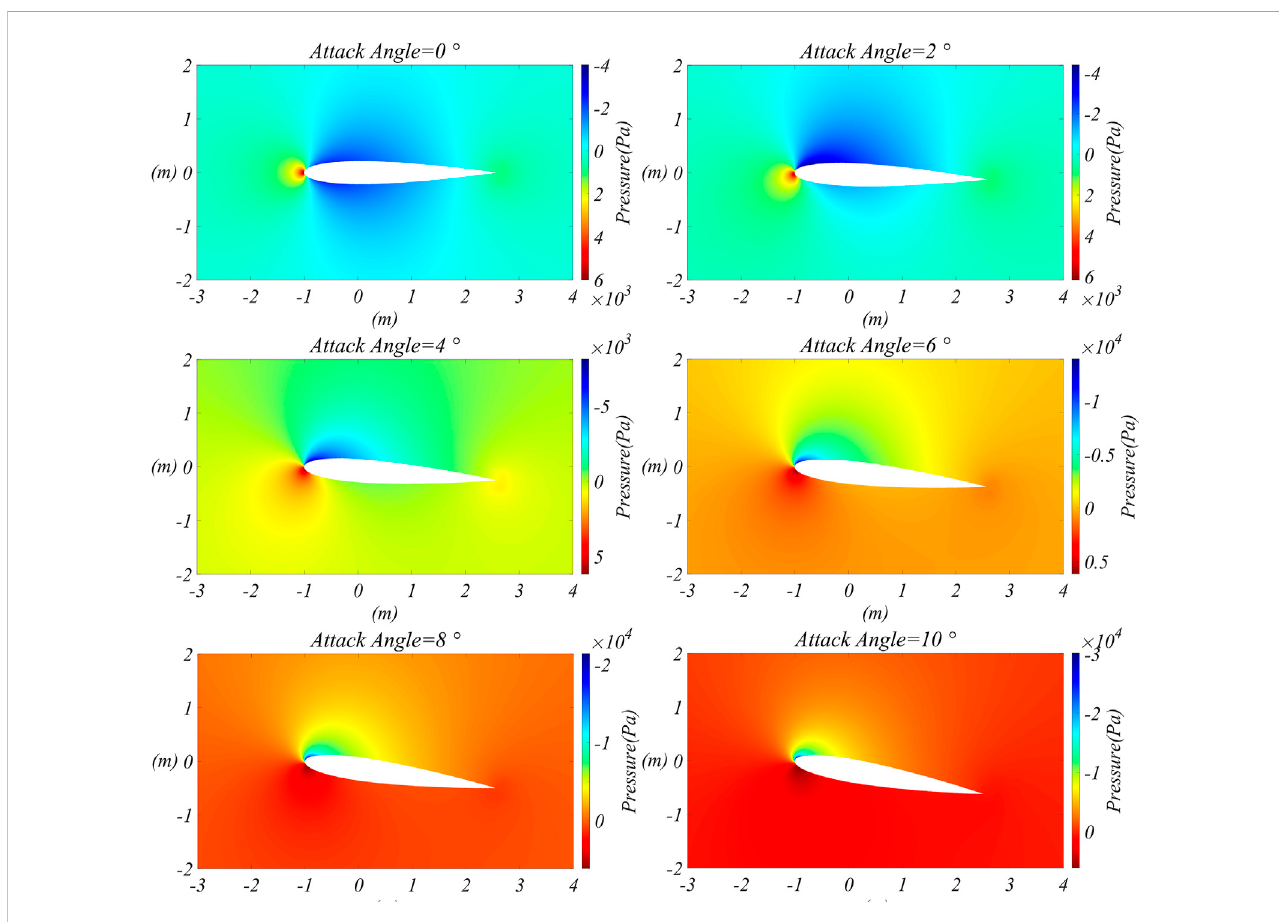
FIGURE 5 The air pressure distribution for different attack angles around wind turbine